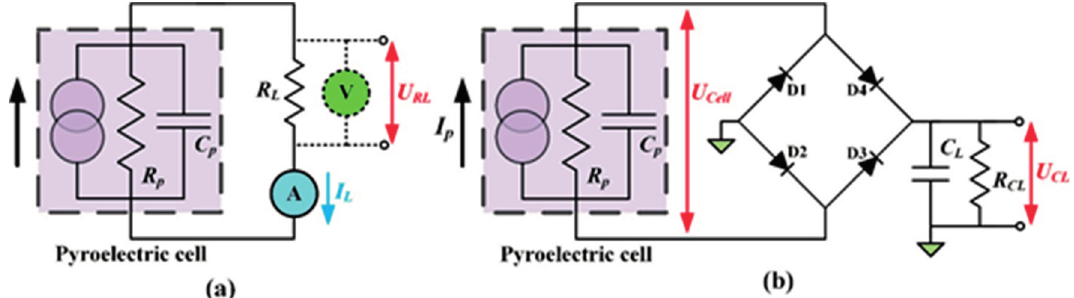
Figure 4. Model of electric energy harvesting process using pyroelectric cells: ( a ) directly driving a load resistance ( R L ); ( b ) using a bridge rectifier to store the electrical energy in a storage capacitor ( C L